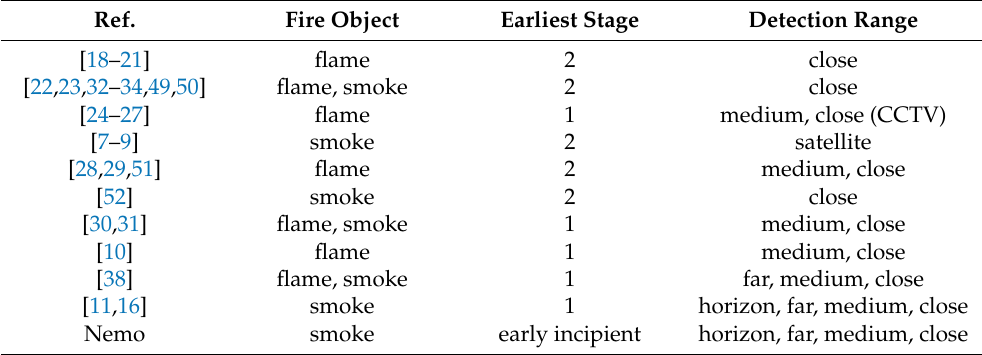
Table 1. State of fire detection. Main differences between existing studies are summarized, using 3 categories for